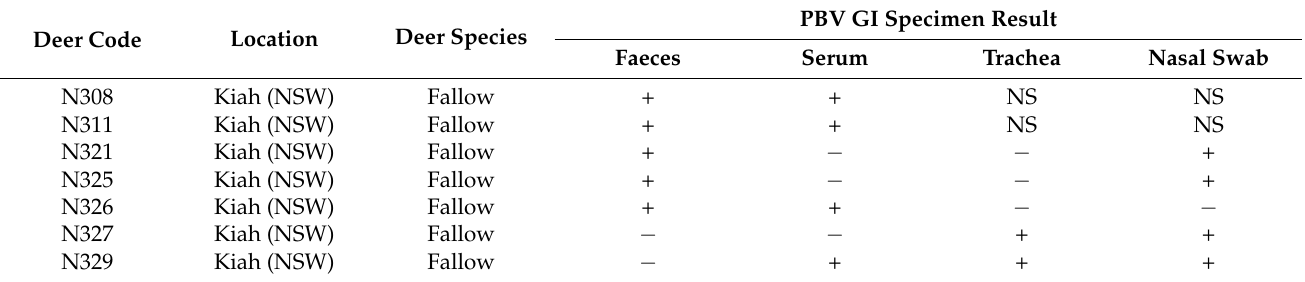
Table 4. Multi-specimen detection of PBV genogroup I.